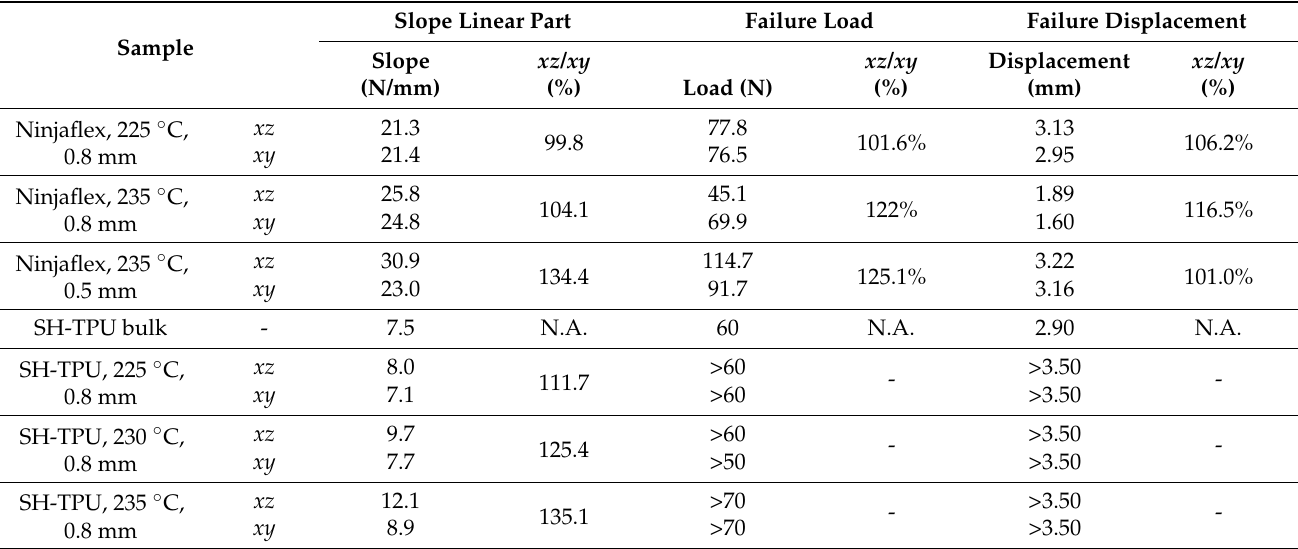
Figure 12. Comparison of the mechanical testing of bulk SH-TPU to 3D printed SH-TPU at 225 °C, 230 °C, and 235 °C with constant infill distance of 0.8 mm. The graph is accompanied by microscopy images of the cross-section in the xz -plane. Scale bars represent 0.5 mm. Table 2. Analysis of the force displacement curves in Figures 11 and